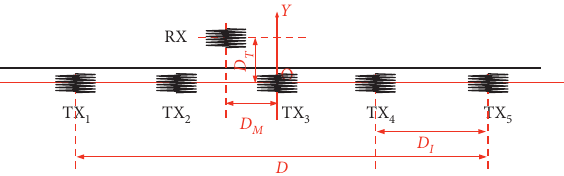
Figure 2: Multiple-TX and single-RX model